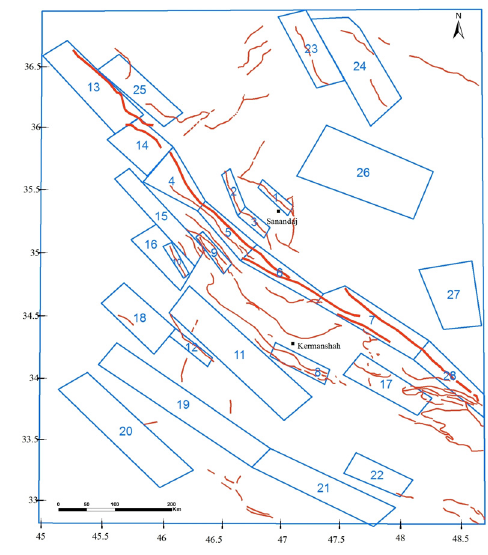
Figure 1. Zagros mountains annotated with Major fault systems, the Sanandaj-Sirjan zone. In set shows Main Recent Fault and the relevant fault segments.